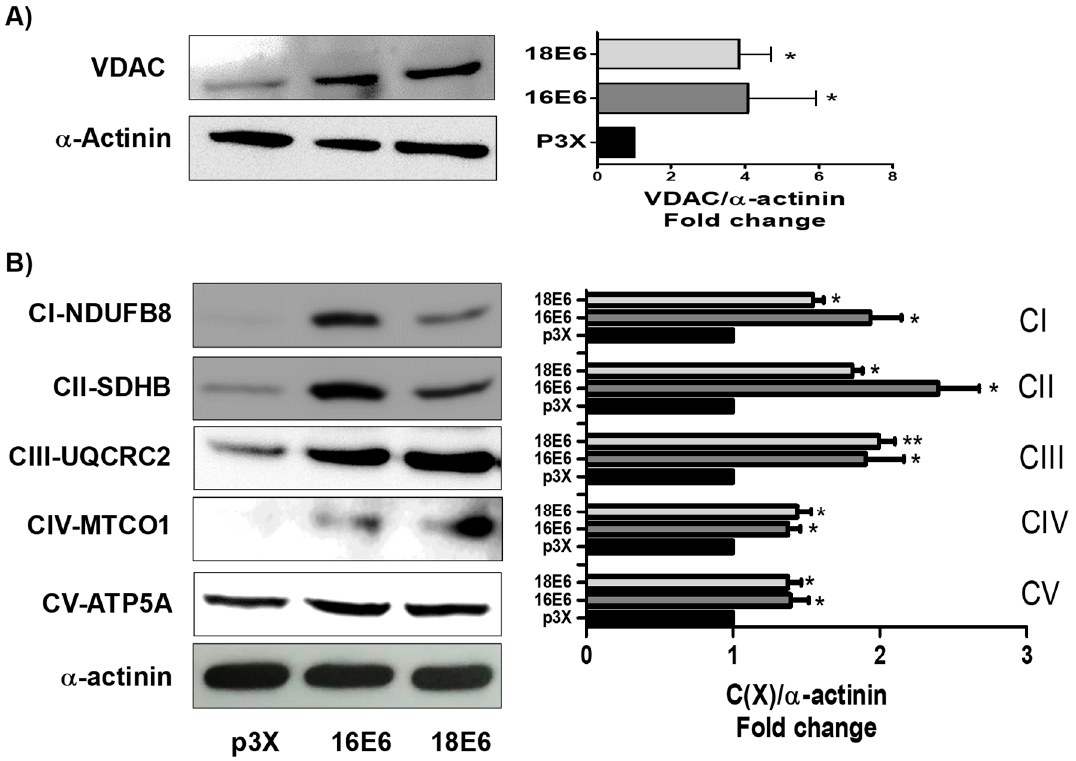
Figure 2. 16E6 and 18E6 oncoproteins increase mitochondrial metabolism in FaDu cells. Human papillomavirus (HPV) E6 oncoproteins increase the protein levels of the subunits of mitochondrial complexes I to IV: Complex I subunit CI-NDUFB8, Complex II subunit CII-SDHB, Complex III-Core protein 2 (CIII-UQCRC2), Complex IV subunit I (CIV-MTCO1), and ATP synthase alpha subunit (CIV-ATP5A), as well as the voltage dependence anion channel (VDAC). ( A ) Representative immunoblot and densitometric analysis of VDAC; and ( B ) Representative immunoblot and densitometric analysis of mitochondrial complexes subunits I-IV and ATP synthase subunit in FaDu transfected cells. α -actinin was used as a loading control. Data are expressed as the mean ± SD. Tukey’s test * p < 0.05 and ** p < 0.005 vs. p3X control, n = 3.